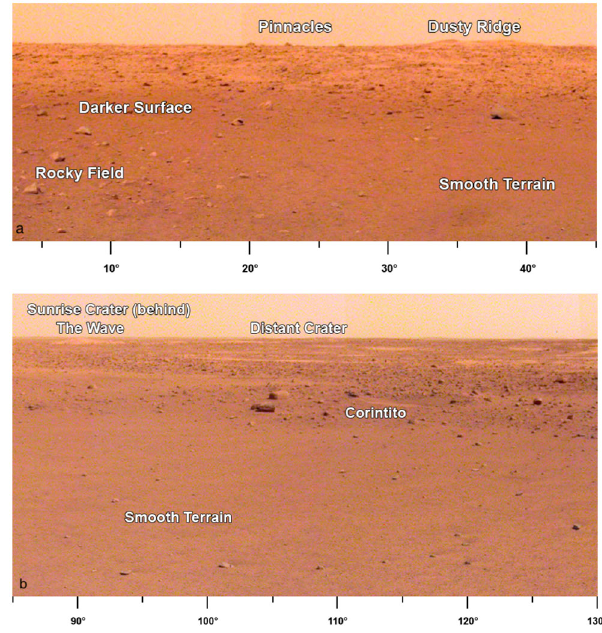
Fig. 6 Portion of panoramas around the lander. a Panorama is the area to the north-northeast of the lander (azimuths below image). Note darker surface where dust has been removed within 20 m of the lander, rockier surface to the west (Rocky fi eld), and smooth terrain to the east. Note The Pinnacles rocks and Dusty Ridge, which is an eolian bedforms on the southern edge of a degraded impact crater, located about 50 m north of the lander. b Portion of panorama to the east-southeast (azimuths below image) of the lander showing smooth terrain to the edge of Homestead hollow and rougher and rockier terrain beyond. Note fresh Corinto secondary crater (Corintito) on the edge of the hollow, circular soil fi lled depressions (hollows) in the distance, and eolian bedforms (The Wave) and Sunrise crater rim on the horizon about 400 m away. The rim of a larger (460 m diameter), relatively fresh crater (Distant crater) to the east- southeast is ~2.4 km